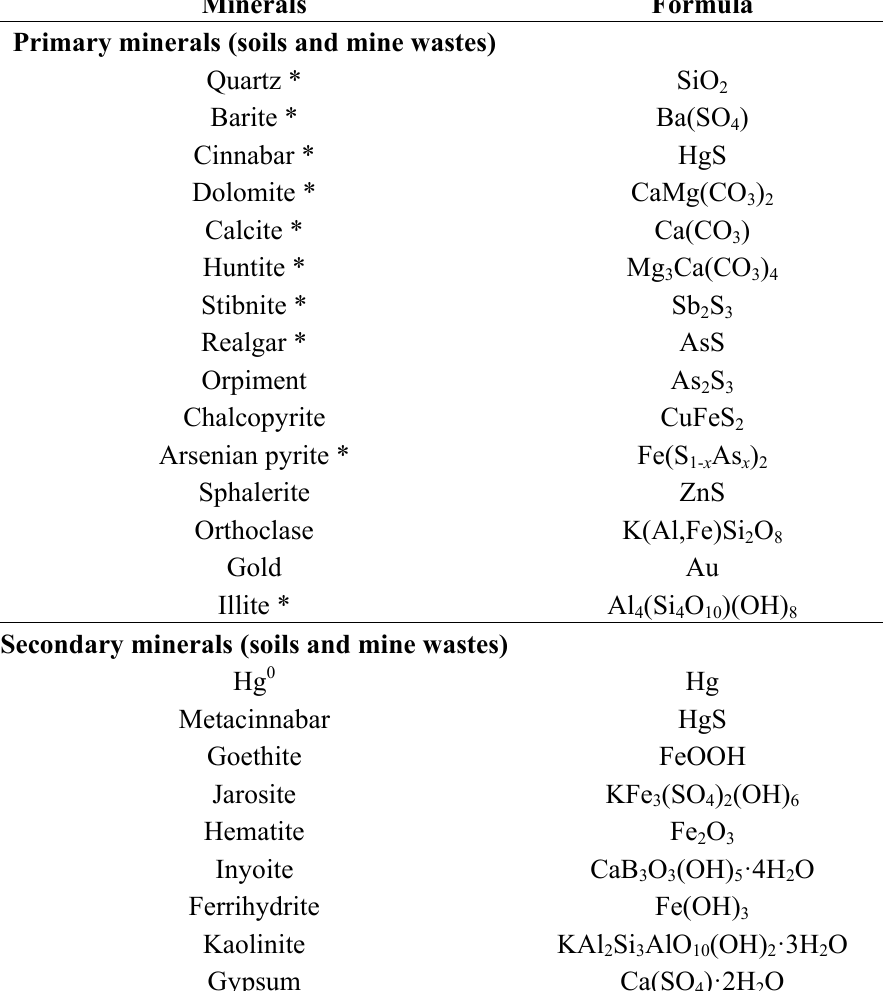
Table 3. Identified minerals in the Valle del Azogue soil and mine wastes and dominant Hg minerals from Hg-thermodesorption curves. Modified from Navarro et al.